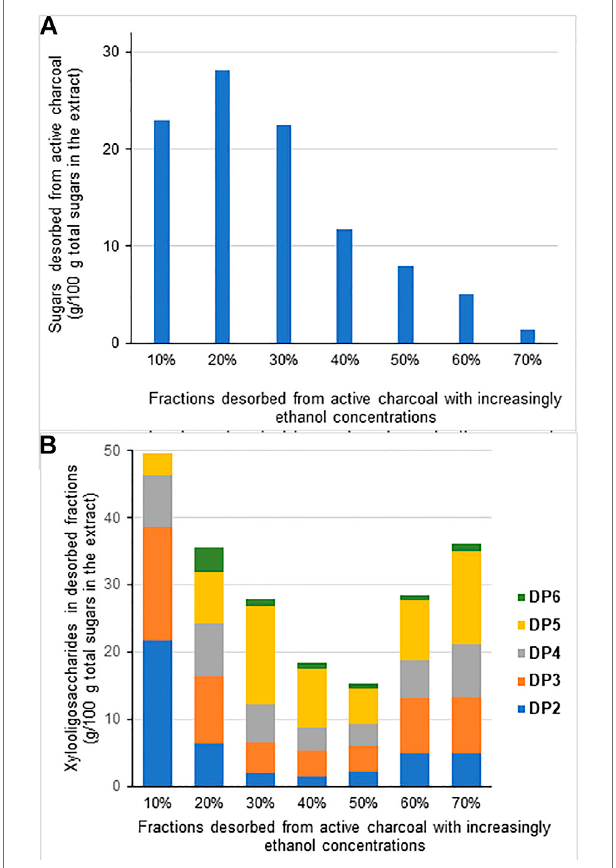
FIGURE 2 | Fractionation of the GAX extract that remained soluble in 90% (v/v) ethanol, as described in Table 2 . Soluble material was adsorbed in active charcoal and desorbed by increasing ethanol concentrations. (A) Sugars desorbed in each fraction related to the total sugars in solution; (B) xylooligosaccharides with DP2 to DP6 identi fi ed in the same fractions illustrated in (A) .